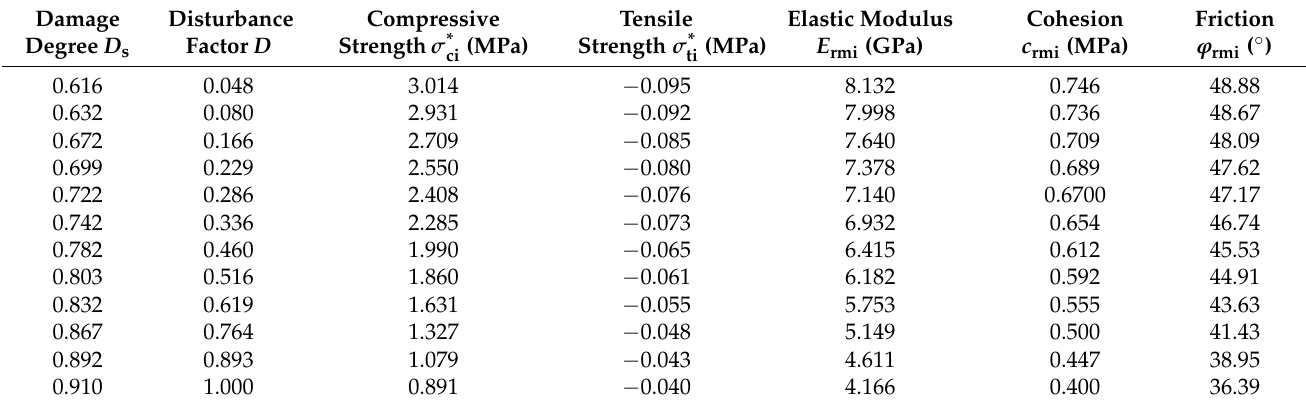
Table 6. Mechanical properties of the rock mass after blasting disturbance.